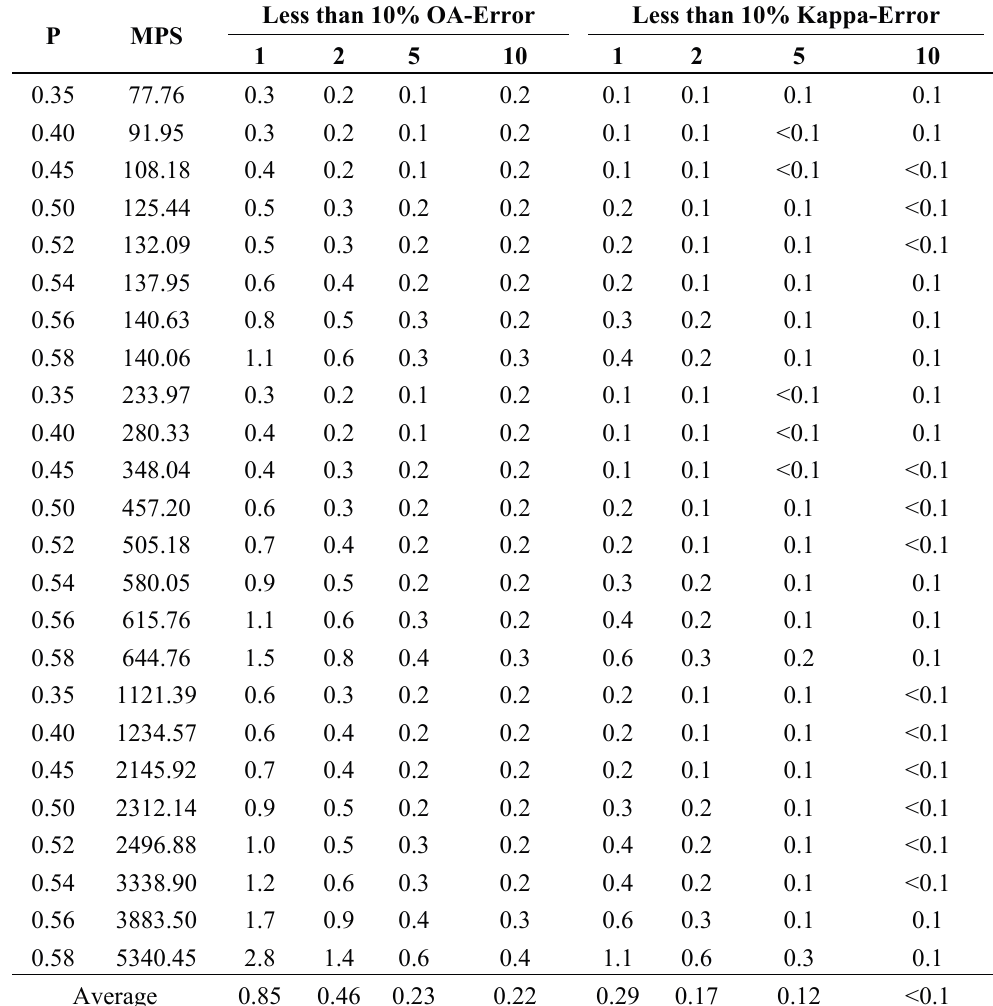
Table 4. The required registration accuracy (# soft pixels) to keep the OA- and kappa-errors under 10% for different landscape characteristics at the spatial resolution of 1, 2, 5, 10 unit distances respectively. (“<” represents “less